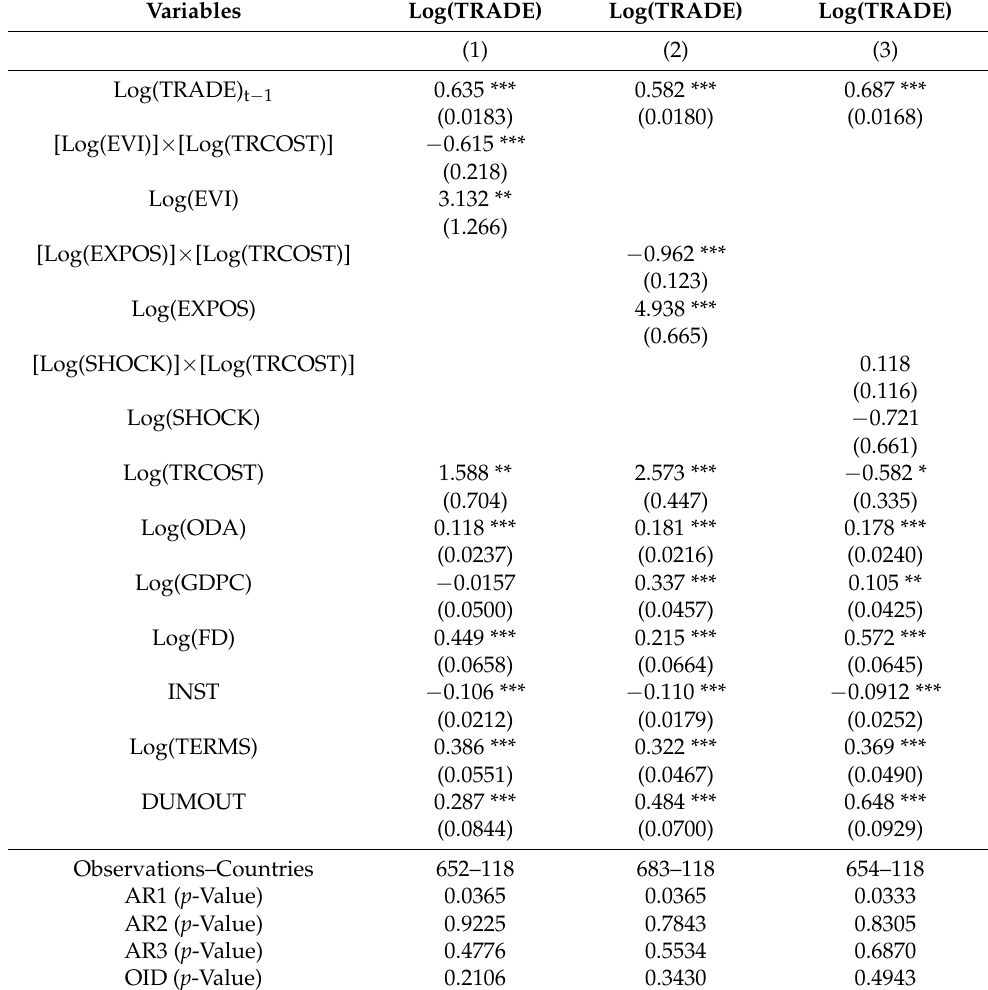
Table 4. Effect of EVI on participation in international trade for varying levels of trade costs. Estimator : Two-step System